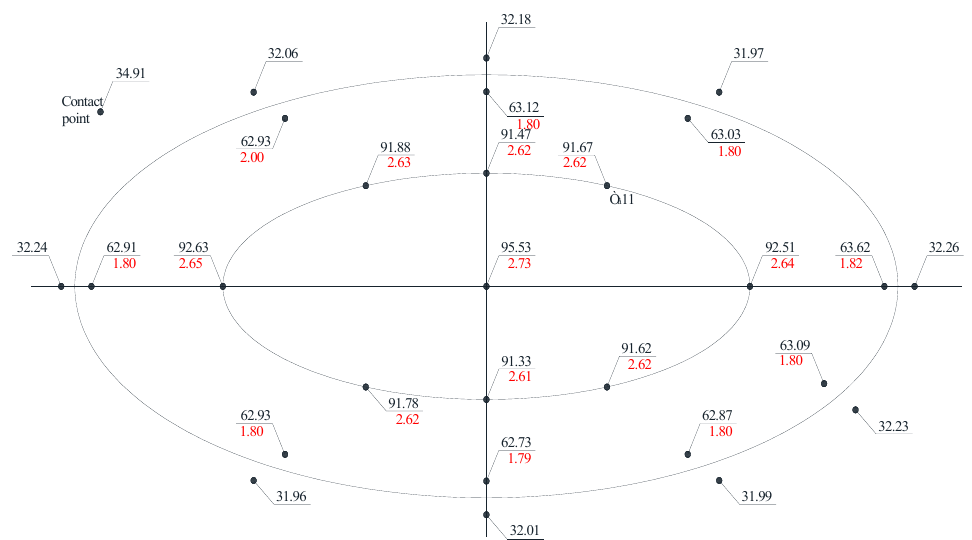
Figure 7. Distribution of hoop stresses at characteristic dent zone points in the wall of the model M2 ‐ A.